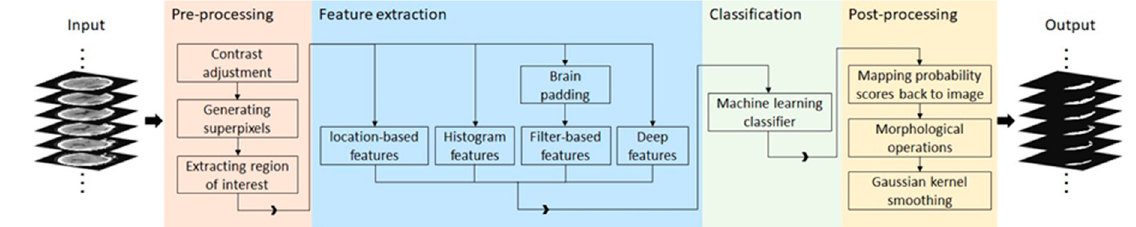
Figure 2. A schematic diagram of the proposed SDH segmentation method.